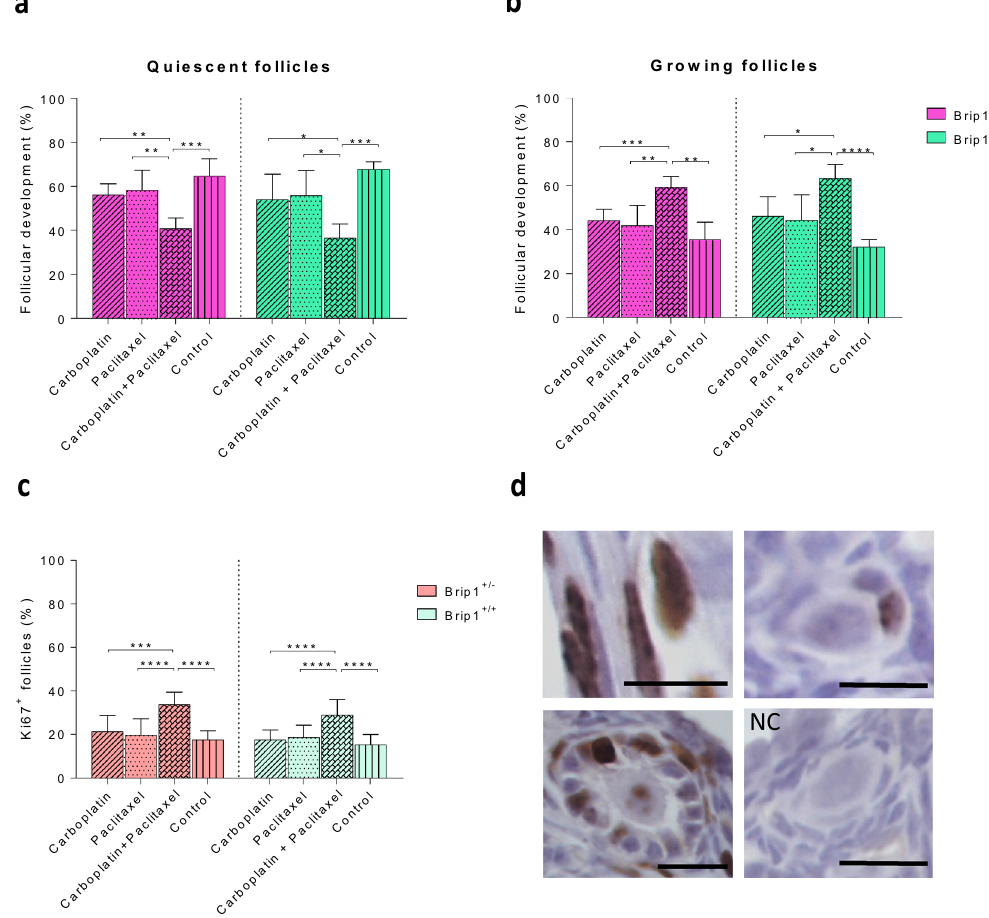
Figure 4. Evaluation of the treatment on follicular activation and development. ( a ) Quiescent follicle (primordial stage) rates and ( b ) growing follicle (primary, secondary and antral stages) rates. ( c ) Proliferative rates of follicles following the treatment. Follicles with at least one granulosa cell stained were counted as positive and reported to the total number of follicles. ( d ) Representative micrographs of Ki67 positive stained follicles. NC, negative control (scale bar 20 μm). Data are presented as mean ± SD; n = 5/treatment/genotype; *p < 0.05, **p < 0.01, ***p < 0.001, ****p <